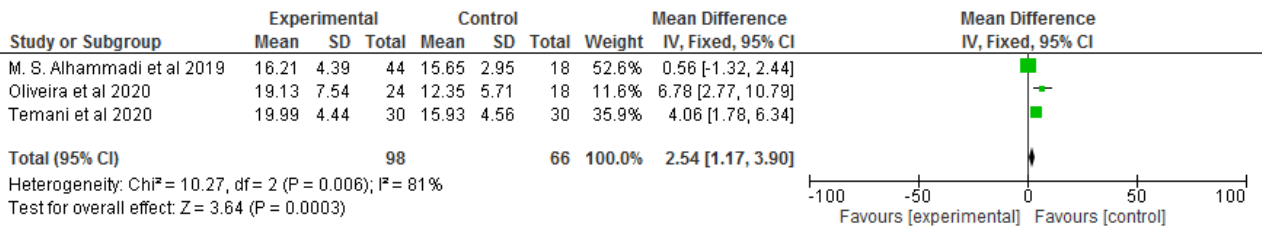
Figure 7. Funnel plot for extraction and non-extraction.